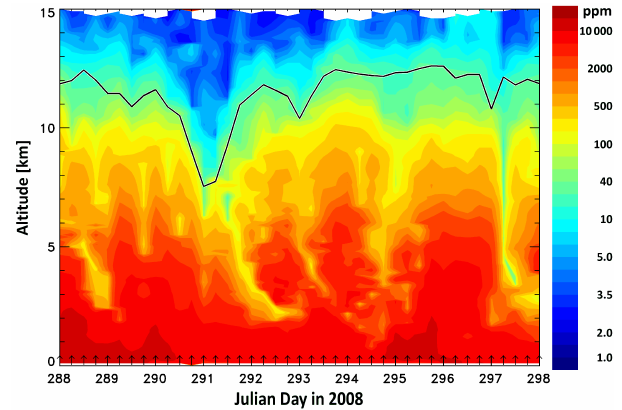
Figure 9. Time series of the water-vapour mixing ratio over Linden- berg during the period between 14 (Julian day 288) and 23 (Julian day 297) October 2008; this figure was derived from radiosonde as- cents at intervals of 6h. The mean flight times (in UTC) are marked by arrows. The thermal tropopause is indicated by a black line. The intrusion examined in this study is visible on Julian days 291 (17 October) and 292. The graphics indicate the passage of a major part of the tropopause fold over Lindenberg.